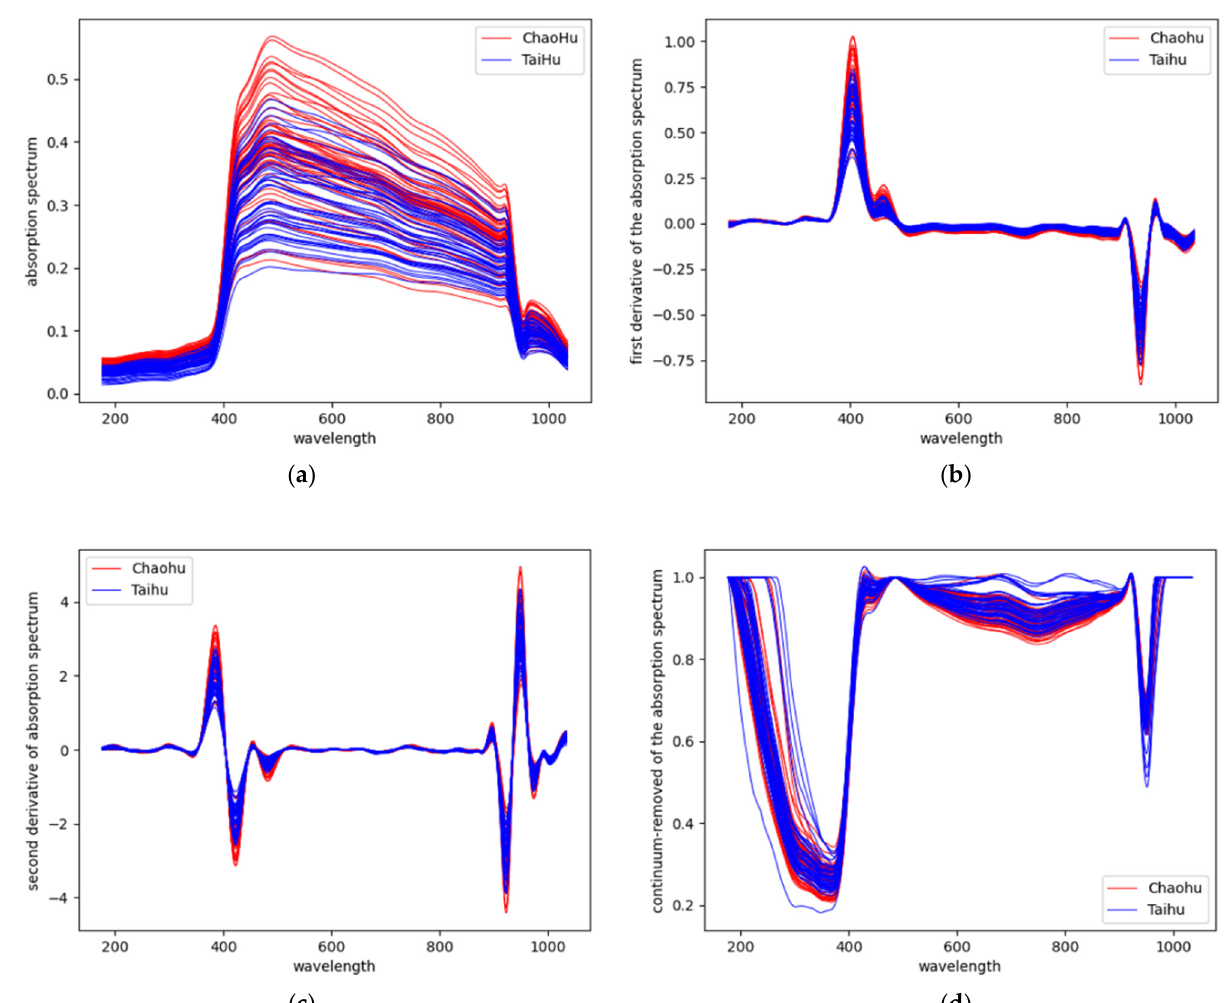
Figure 7. Spectral curves of test data (a) Original absorption spectrum (b) Original absorption spectrum were processed using first-order differentiation (c) Original absorption spectrum were spectrum were processed using first-order differentiation ( c ) Original absorption spectrum were processed using second-order differentiation (d) Original absorption spectrum were processed processed using second-order differentiation ( d ) Original absorption spectrum were processed using using continuum removal. continuum